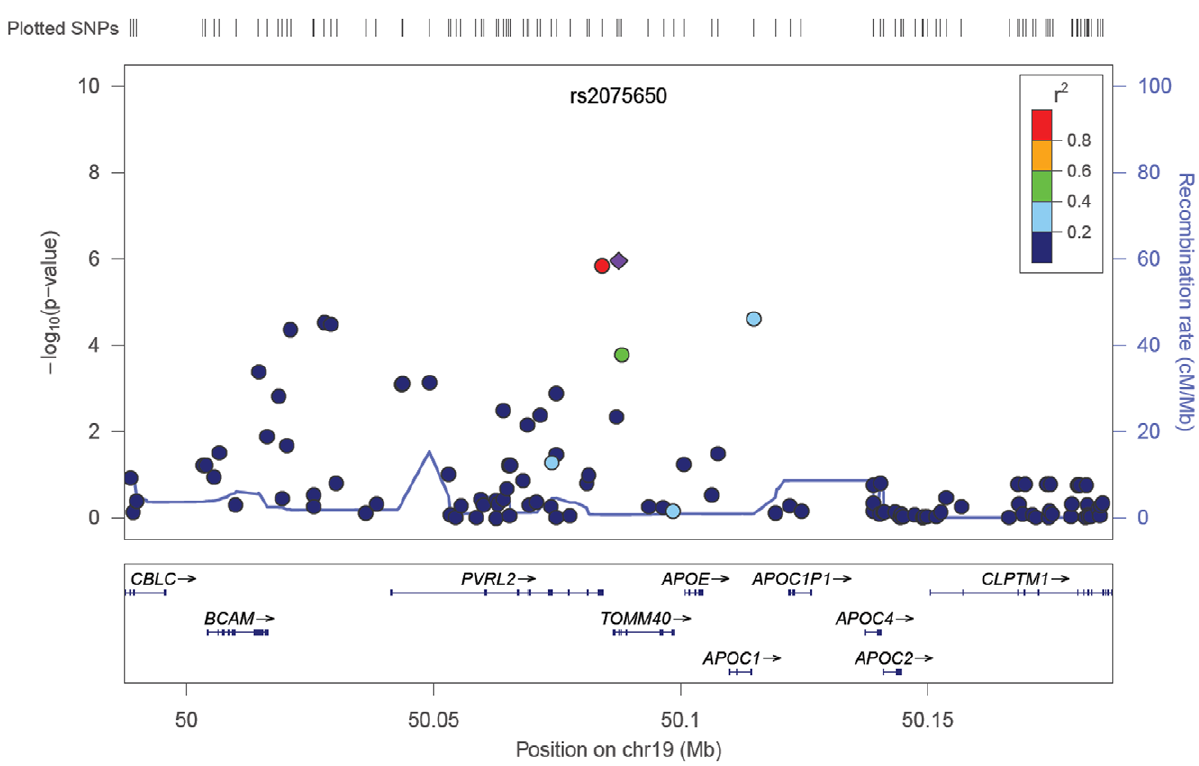
Figure 3. Regional association results for chromosome 19 SNPs in the PVRL2 / APOE / TOMM40 gene cluster. The index, associated SNP is named and shown as a purple diamond (rs2075650: P =1.1 6 10 2 6 ).